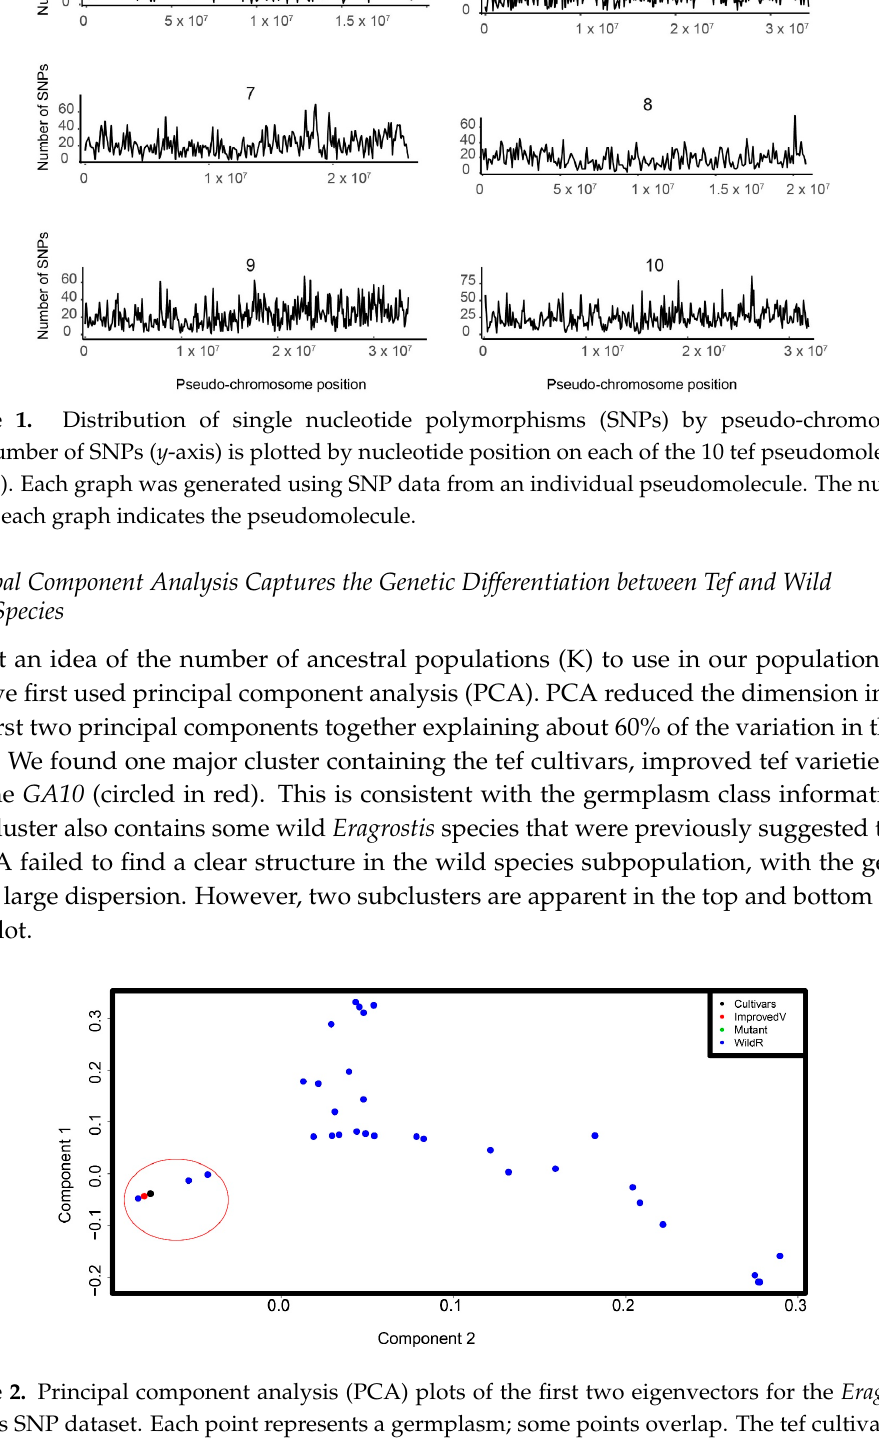
Figure 2. Principal component analysis (PCA) plots of the first two eigenvectors for the Eragrostis species SNP dataset. Each point represents a germplasm; some points overlap. The tef cultivars, all improved varieties, and the mutant line are genetically close and were grouped together (circled in red). The mutant line (indicated by green point) cannot be shown on the figure as it is overlapping with the tef cultivars. The wild Eragrostis species are dispersed without apparent structure. However, three species in the bottom right corner and five species in the top corner are grouped together.